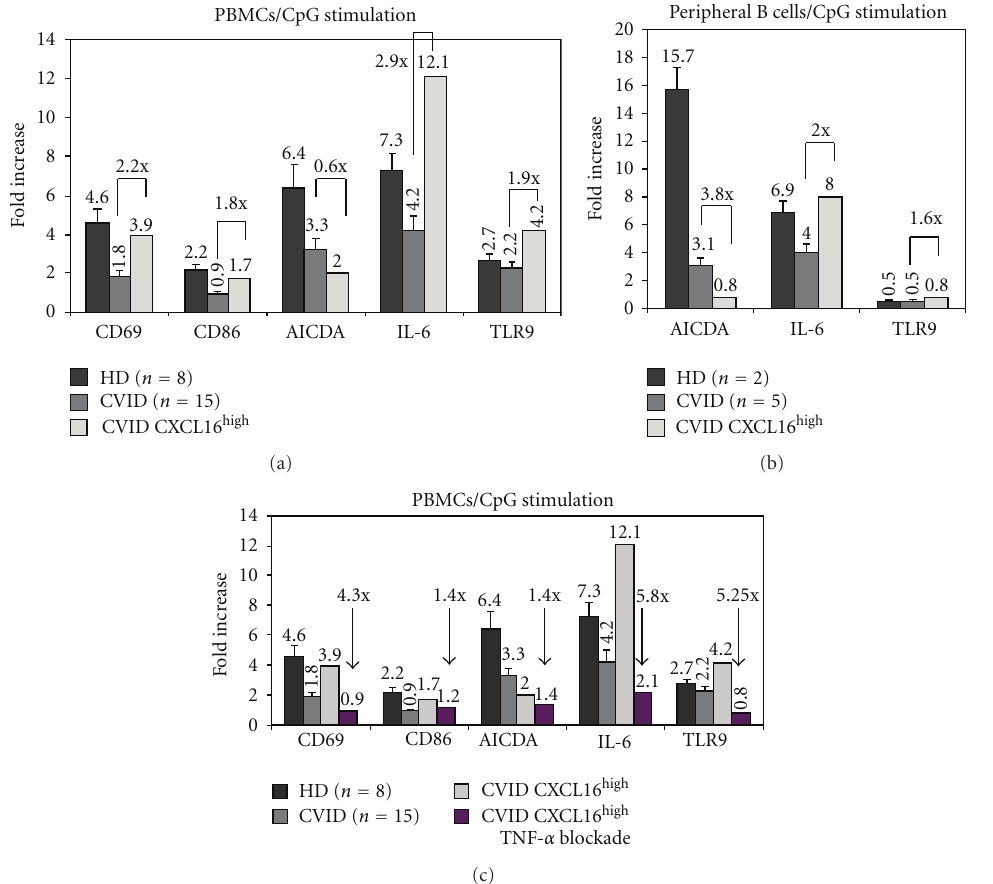
Figure 6: CXCL16 high B cell responses to CpG. (a) Evaluation of target gene (mRNA levels) upregulation (mRNA levels) after in vitro stimulation with CpG. Fold increase of CD69, CD86, TLR9, AICDA, and IL-6 at the mRNA level after CpG stimulation. Experiments were performed with PBMCs in triplicates for all patients ( n = 15) and healthy controls ( n = 8). (b) Fold increase of TLR9, AICDA, and IL-6 at the mRNA level after CpG stimulation. Experiments were performed with purified B cells from patients ( n = 5) and healthy controls ( n = 2). Graph bars show standard error (SE). (c) Evaluation of target gene (mRNA levels) upregulation (mRNA levels) after TNF- α blockade and in vitro stimulation with CpG. Fold variation of CD69, CD86, TLR9, AICDA, and IL-6 at the mRNA level is showed. Experiments were performed with PBMCs in triplicates for all patients ( n = 15) and healthy controls ( n = 8). Graph bars show standard error